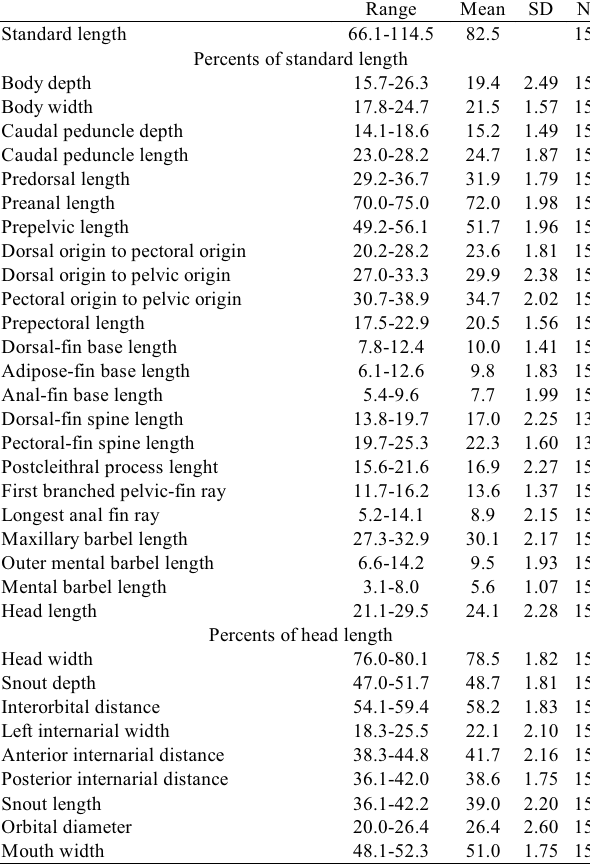
Table 6. Morphometric data for Tatia dunni . SD = standard